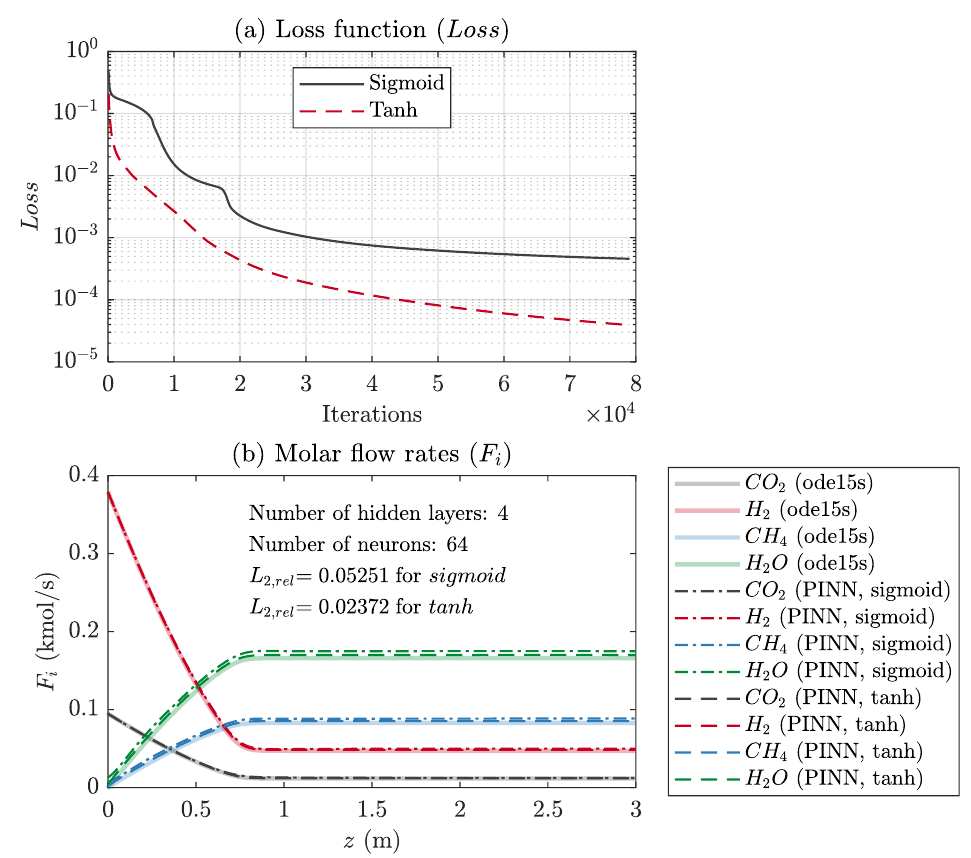
Figure 4. ( a ) History of the loss function ( Loss ) and ( b ) comparison of the mole flow rates ( F i ) of the exact ODE solutions ( F i,ODE ) and PINN solutions ( F i,PINN ) with the sigmoid and tanh activation functions.